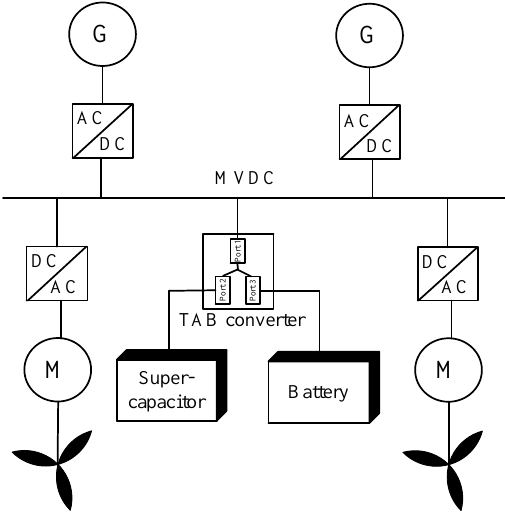
Figure 22. Proposed TAB converter for future all-electric